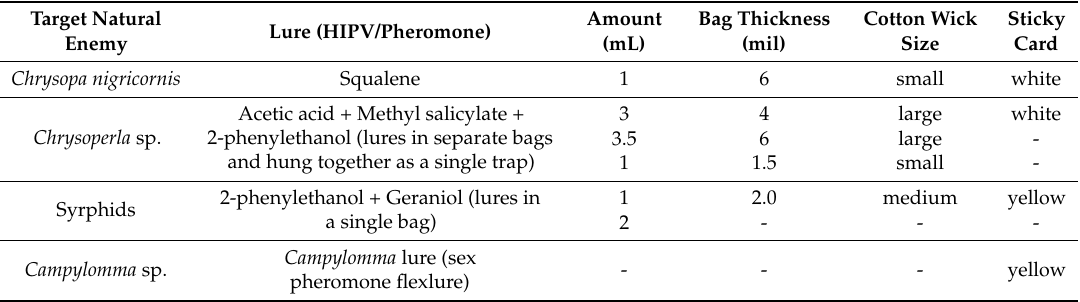
Table 1. Target natural enemy and trap information for herbivore-induced plant volatiles (HIPVs) and a pheromone lure used to monitor natural enemy abundance in a pear orchard in White Salmon, WA, during May to August